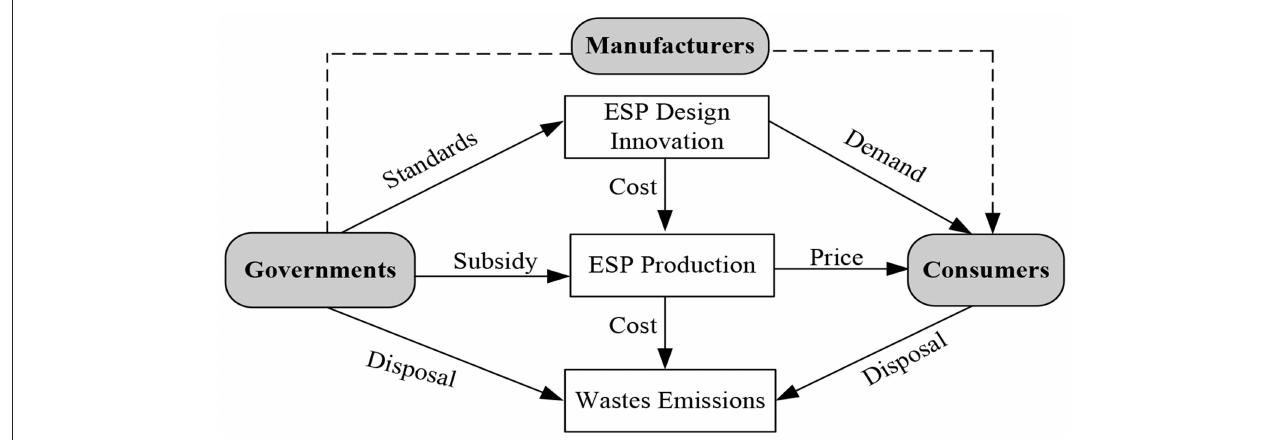
FIGURE 1 | The relationships among governments, manufacturers, and consumers of ESPs.